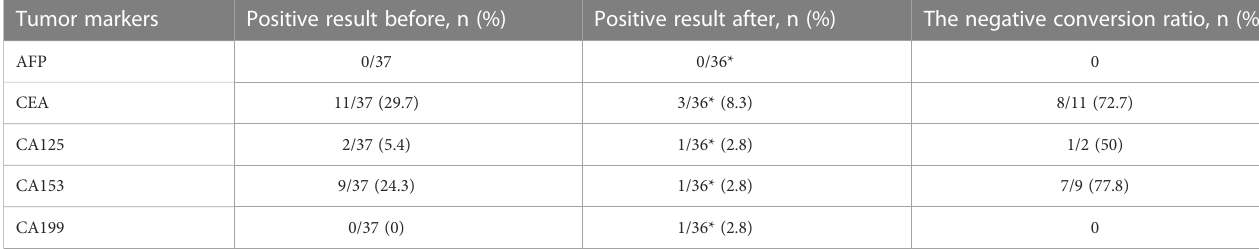
TABLE 3 The negative conversion ratio of tumor markers after neoadjuvant therapy.